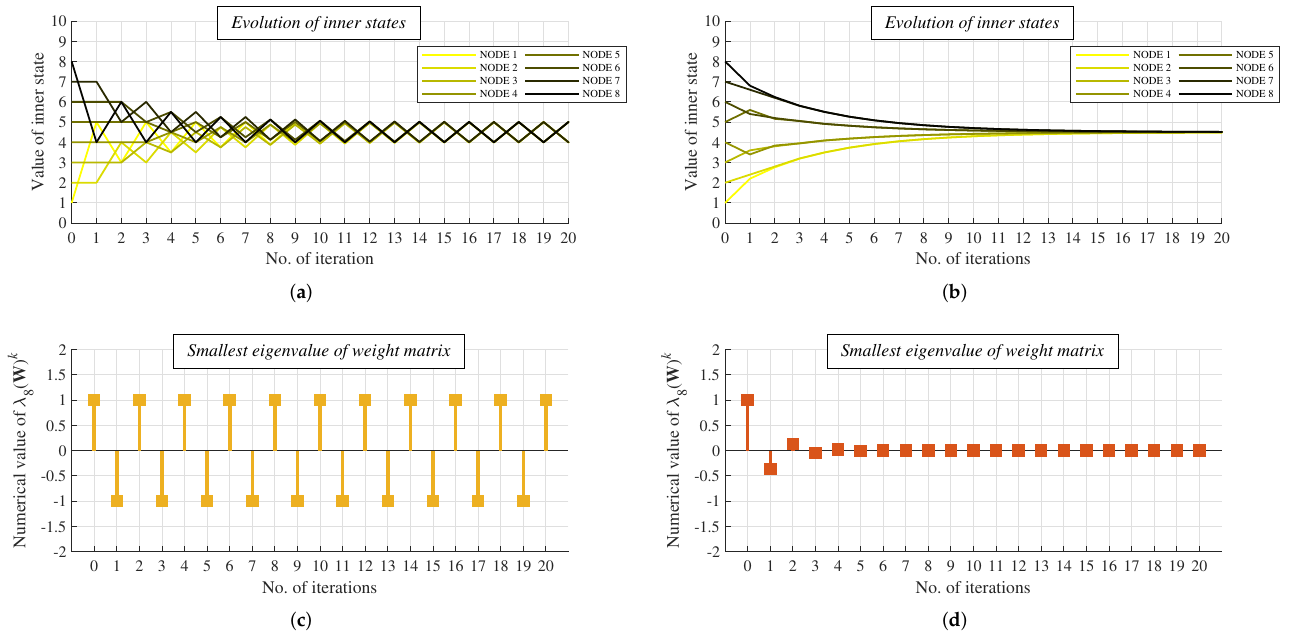
Figure 12. Comparison of evolution of inner states and smallest eigenvalue of weight matrix in bipartite regular connected and non-bipartite non-regular connected graph formed by eight vertices and with mixing parameter equal to 1/ ∆ − example. ( a ) Evolution of inner states in bipartite regular connected graph. ( b ) Evolution of inner states in non-bipartite non-regular connected graph. ( c ) Evolution of smallest eigenvalue in bipartite regular connected graph. ( d ) Evolution of smallest eigenvalue of weight matrix in non-bipartite non-regular connected